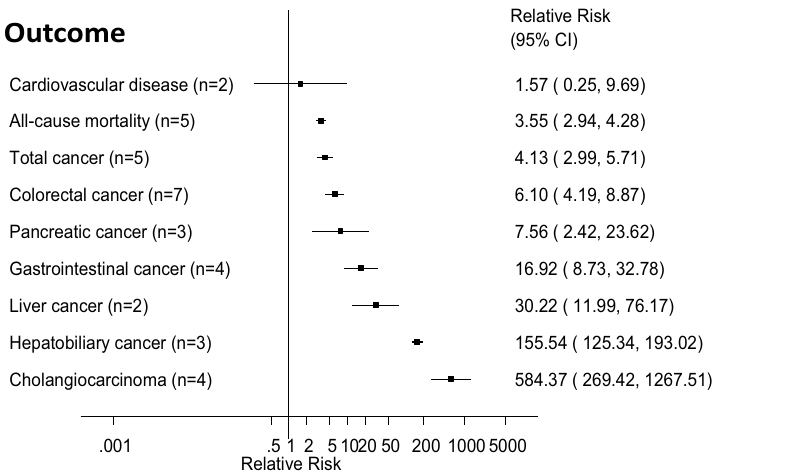
Figure 1. Flow-chart of study selection.